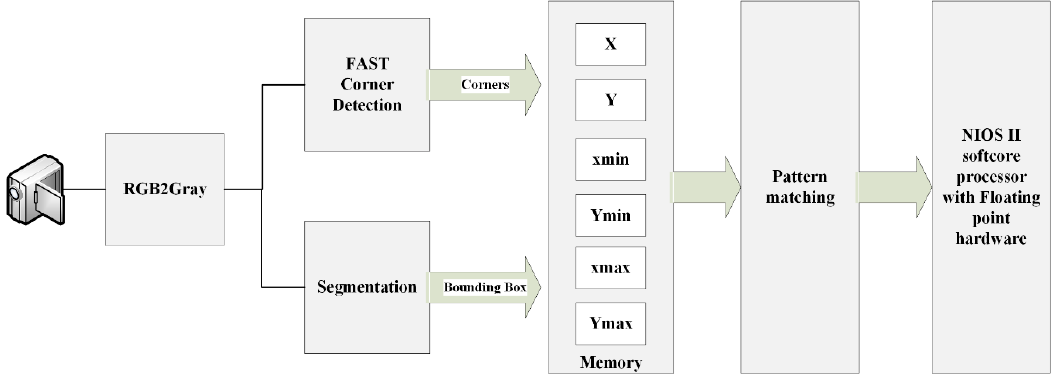
Figure 1. Top level architecture.